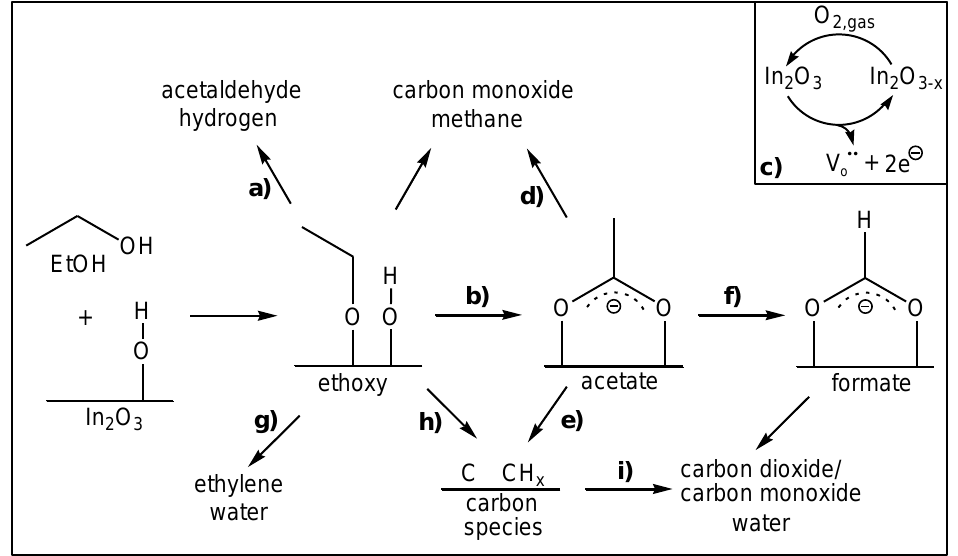
Figure 8. Proposed mechanism of the ethanol gas sensing of indium oxide. For details see text. Reproduced from [5].